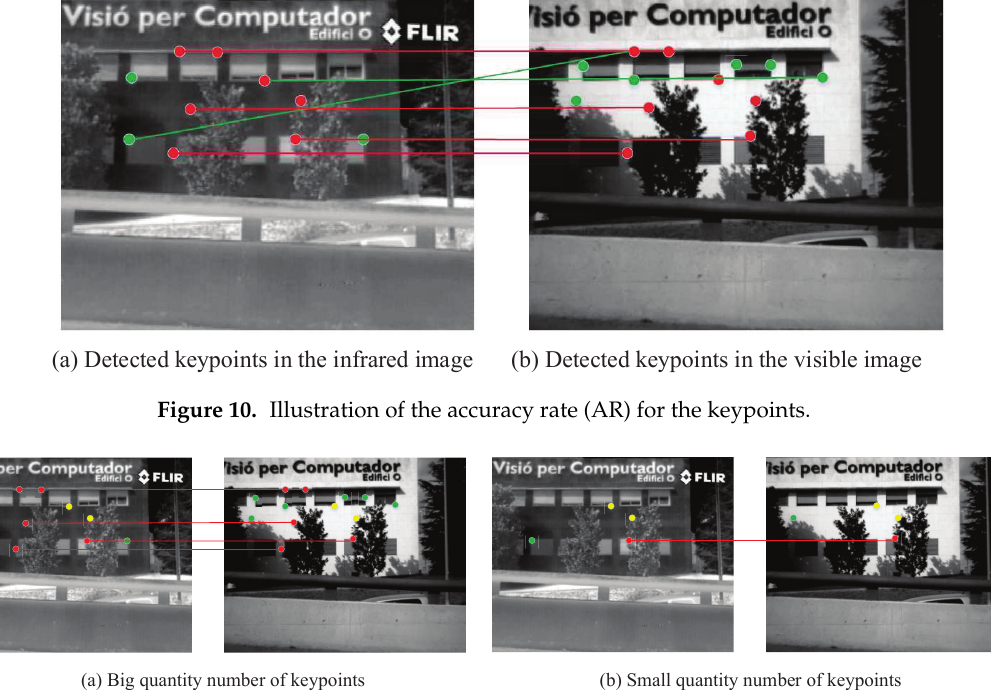
Figure 11. Illustration of the quantity rate (QR) for the